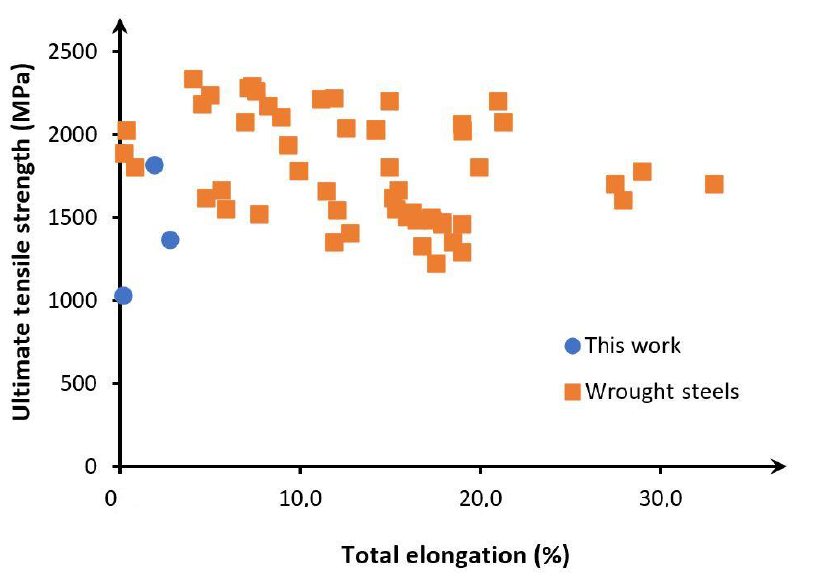
Figure 19. Chart showing ultimate tensile strength versus total elongation of the microstructures developed in this work against those reported for other wrought advanced bainitic steels [20,75–77,80].